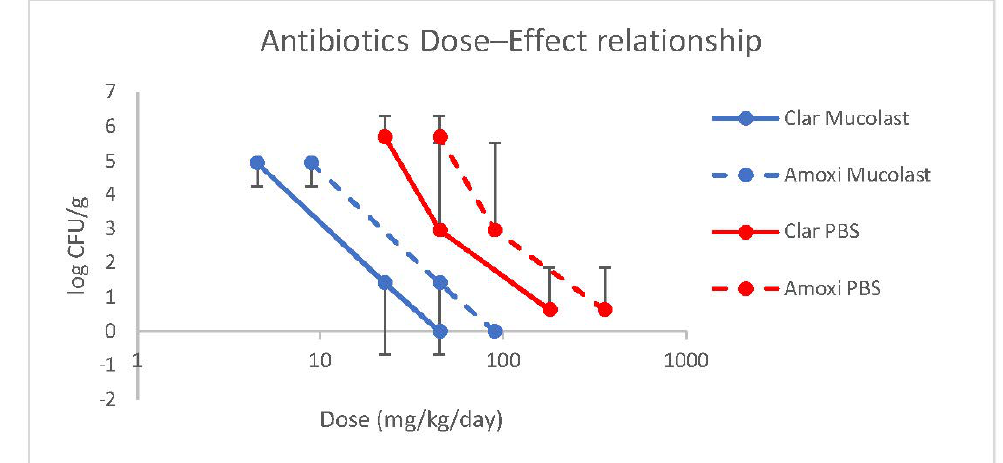
Figure 7. Amox and Clar dose–effect relationship of Mucolast ® and PBS.